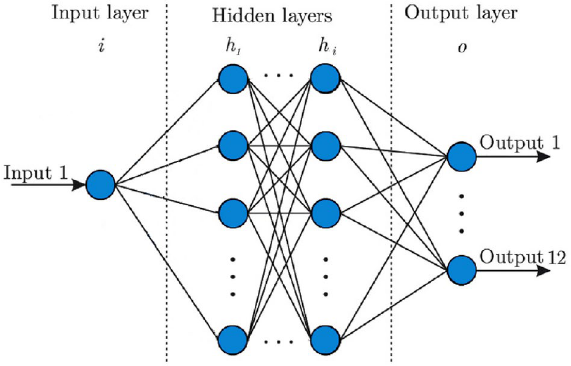
Figure 1. An example of a neural network with i hidden layers, 1 input layer and 12 output layers.